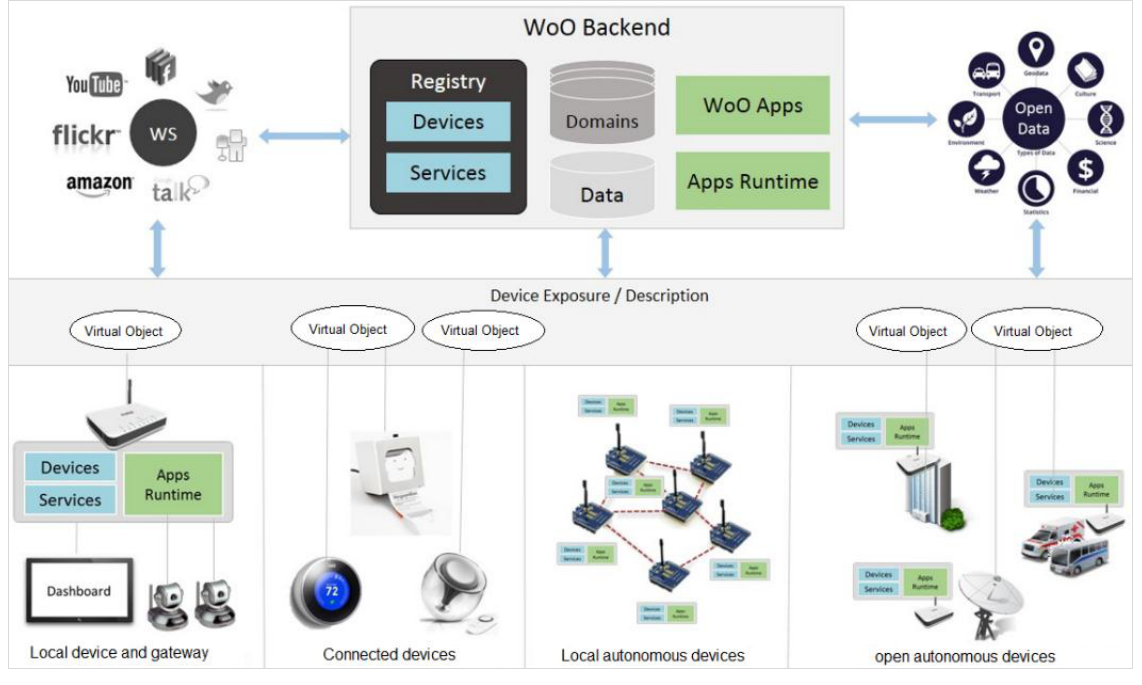
Figure 1. Real world physical objects, such as physical devices, gateways, local and open autonomous devices are connected and virtualized in the WoO concept